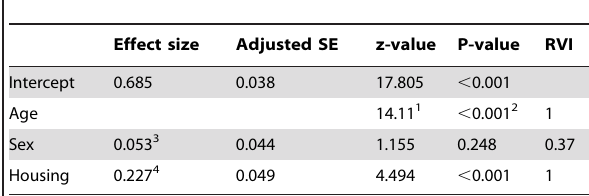
Table 1. Estimated effect size, adjusted standard error (SE), z- value and relative variable importance (RVI) estimated by a generalized additive model to determine the effects of age (as spline), housing and sex on RTL